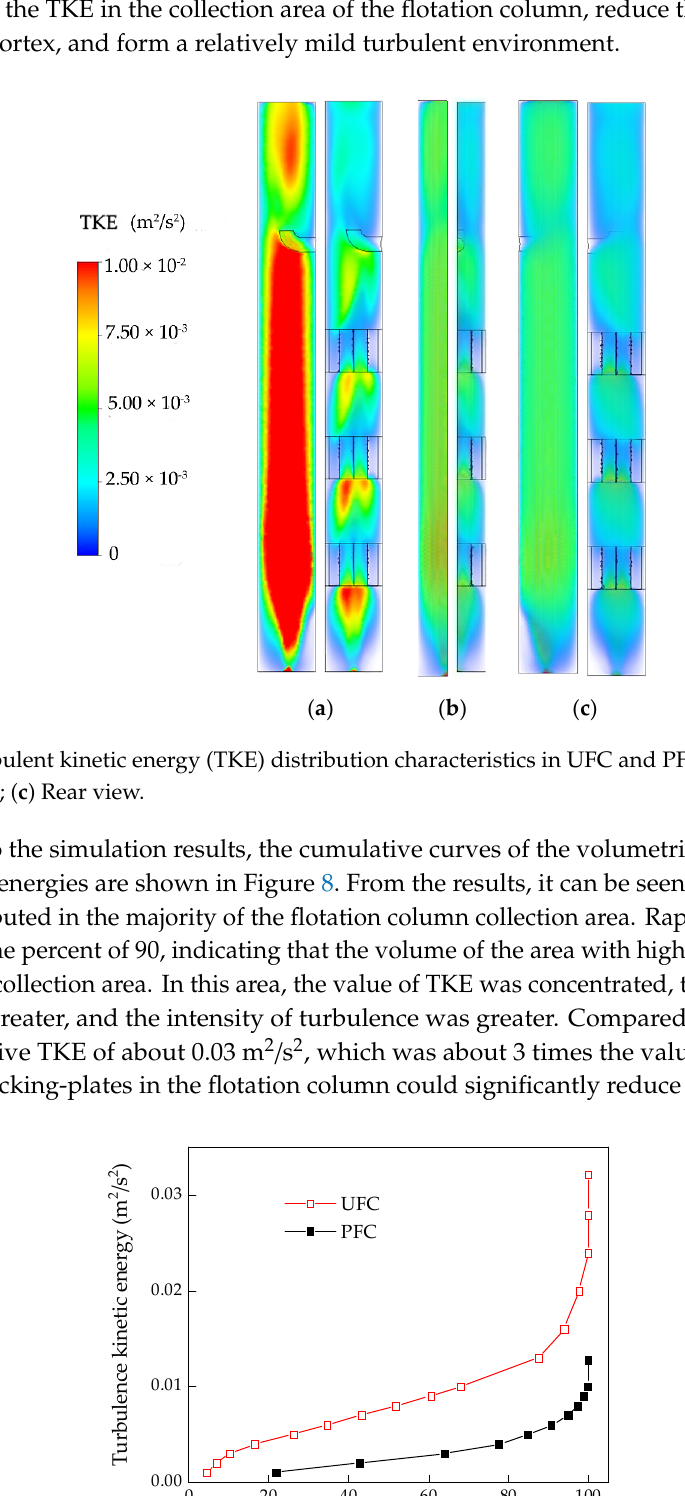
7 of 11 Figure 6. Images of the bubbles captured in UFC and PFC: ( a ) Bubbles in UFC; ( b ) Bubbles in PFC. 3.3. Turbulence Characteristics